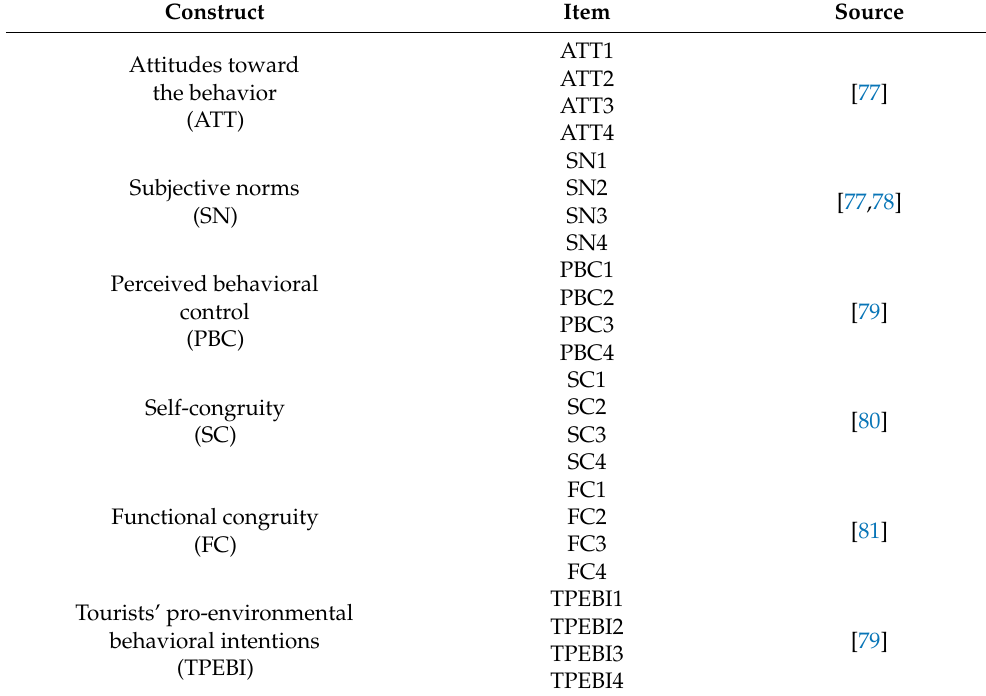
ATT1 [77]ATT2 ATT3 ATT4 SN1 SN4 PBC1 PBC4 SC1 SC4 FC1 FC4 TPEBI1 [79]TPEBI2 TPEBI3